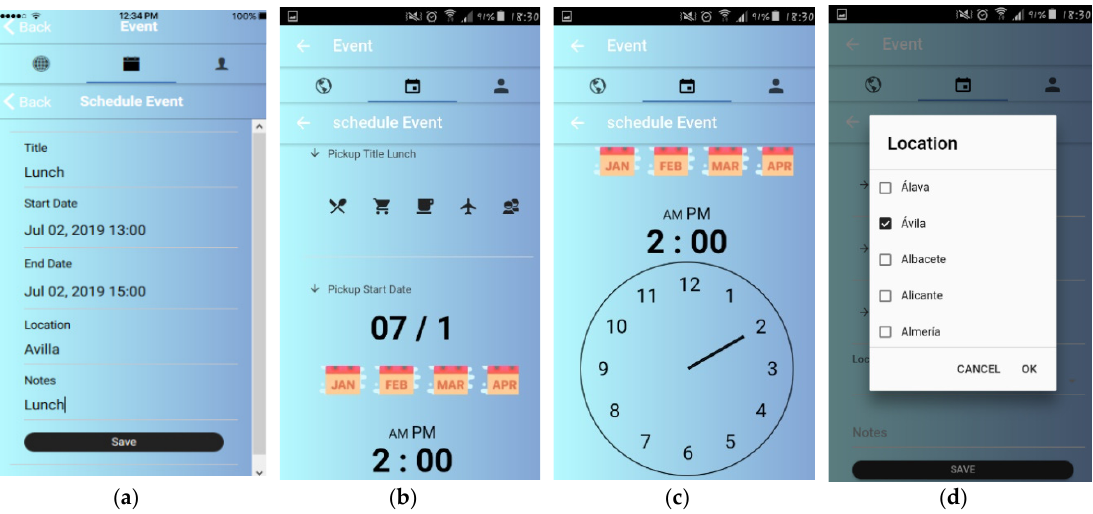
Figure 11. UI interfaces for event scheduling. ( a ) Traditional interface, ( b ) event setup, ( c ) time configuration, ( d ) location